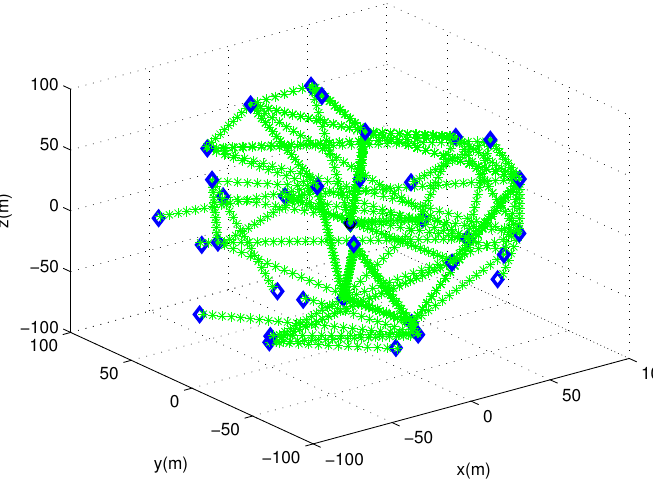
Figure 4. The path of each maneuvering AR until the 3D sphere is entirely covered ( r sc = 70 m). The path of a maneuvering AR is depicted with green line segments. The final position of a maneuvering AR is depicted as a blue diamond. See that blue diamonds are marked at end points of each line segment.